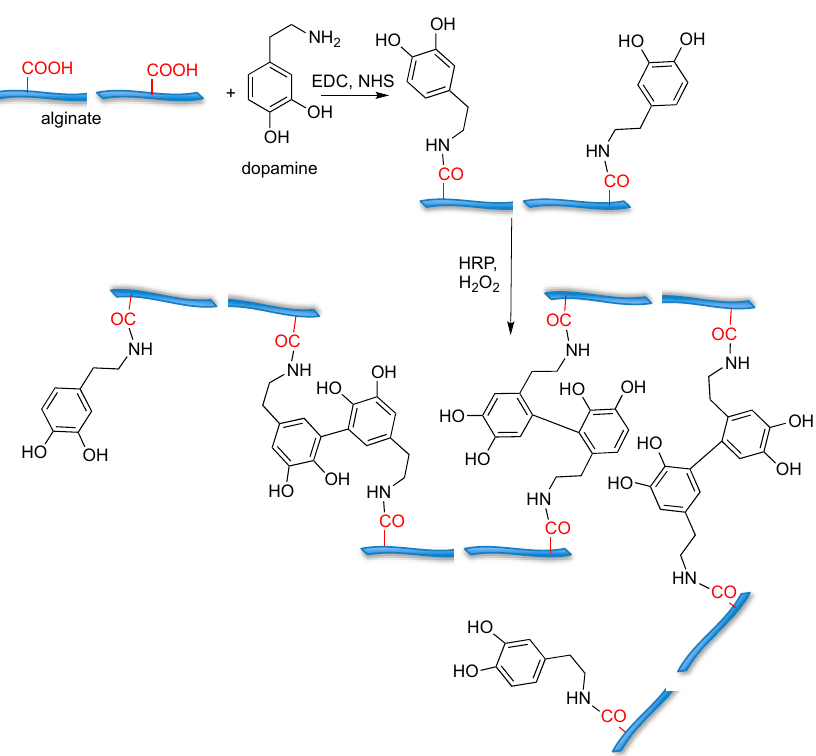
Figure 7. Alginate-based hydrogels cross-linked through dopamine oxidation by horseradish peroxidase (HRP); biocompatibility was assayed with NIH 3T3 cells. Other small molecule motifs have been proposed for the formation of biofunctional supramolecular hydrogels, such as bisphosphonates or glucosamine, that showed wound-healing properties [68].